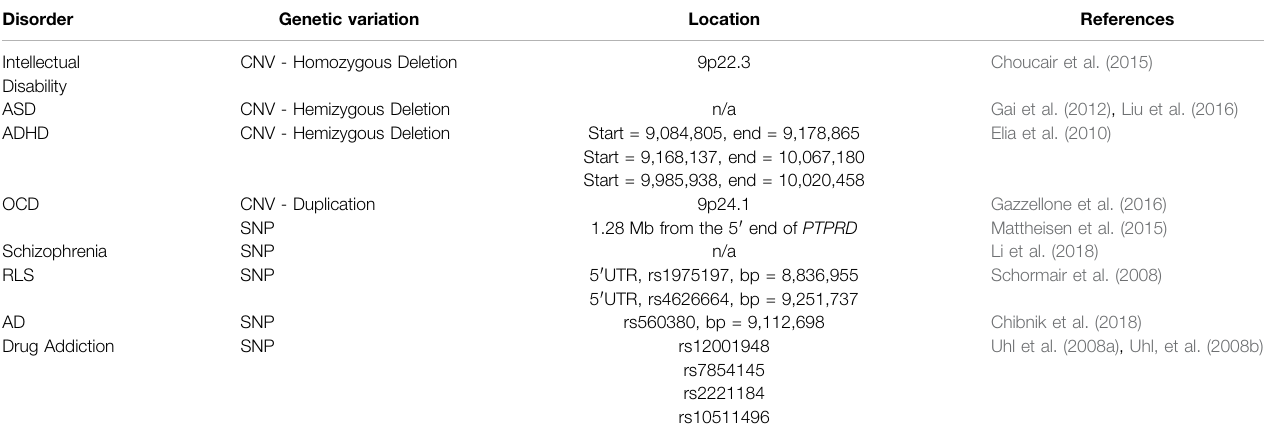
TABLE 2 | Brain disorders induced by PTPRD mutations. Mutations in PTPRD have been associated with the development of several brain disorders such as intellectual disabilities, ASD, ADHD, OCD, schizophrenia, RLS, AD, and drug addictions. PTPRD genetic variations and its genomic location observed for each brain disorder are